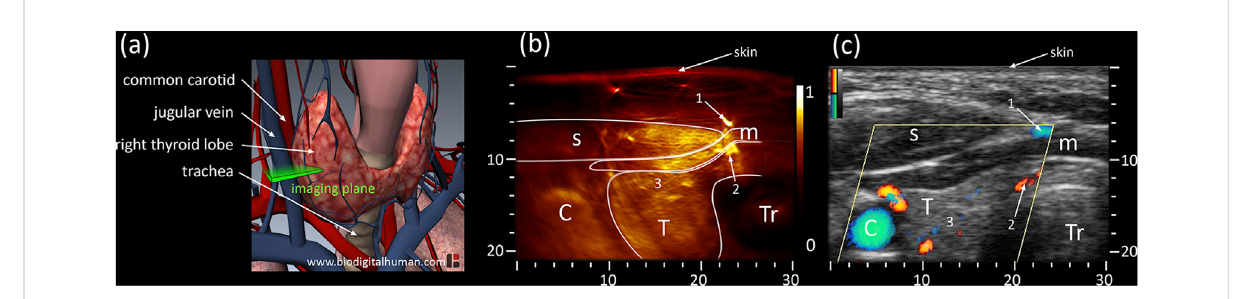
FIGURE 3 (A) Anatomy of thyroid including cardio-vascular and respiratory system; the cross-sectional imaging plane is highlighted in green. (B) PAT and (C) US cross-sections of the left thyroid lobe of the fi rst volunteer. PAT: Photoacoustic tomography, US: Ultrasound; C: Carotid T: Thyroid, Tr: Trachea, s: sternocleidomastoidmuscle, m:infrahyoid muscle; axesinmm. Reprintedwith permission from [DimaA., Ntziachristos V.(2016). In-vivo handheld optoacoustic tomography of the human thyroid[J]. Photoacoustics, 4(2):65 – 69. doi: